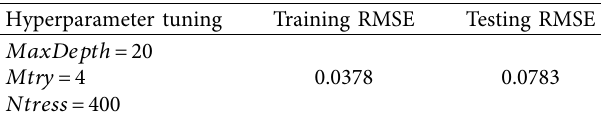
Figure 6: (a) Feature selection and (b) variable importance. Table 3: Random Forest hyperparameter tuning and modeling